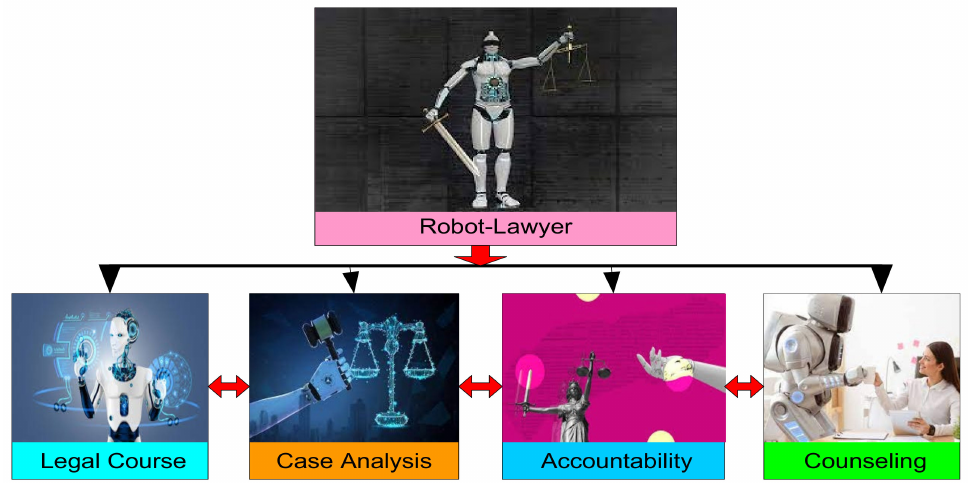
Figure 3. AI-enabled Robotic Lawyer revamping the Legal